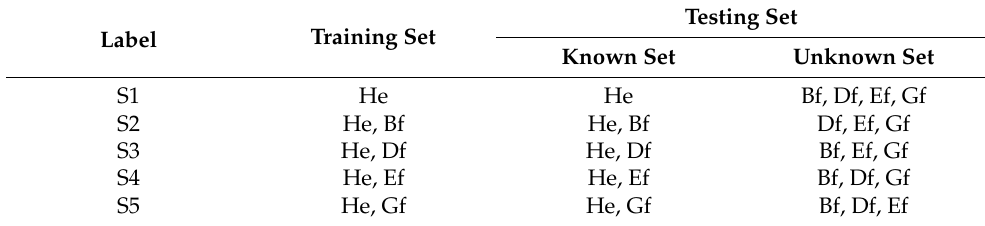
Table 1. Experimental set for each training and testing